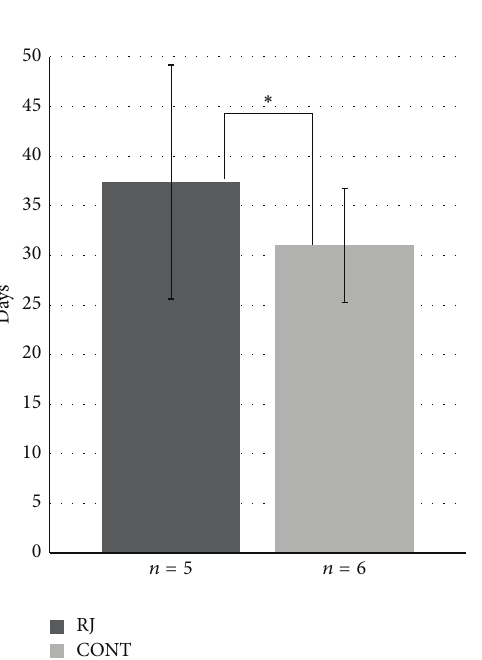
Figure 2: Time to progress to G2 mucositis. Each data point represents the mean ± SD. Mann-Whitney 𝑈 test: ∗ 𝑃 < 0.001 versus control.